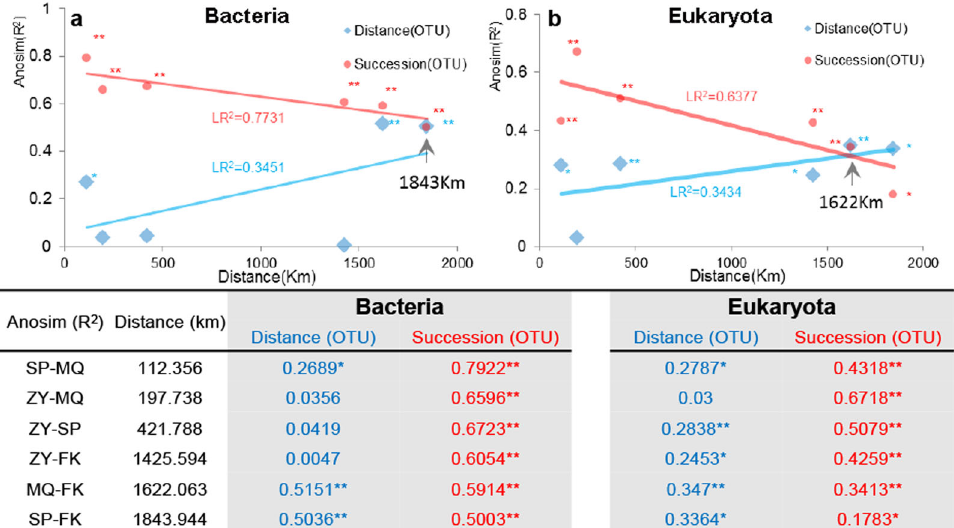
Fig. 2 Community differences varied with distance in succession and geography at regional scales. Sample sites contained FK, ZY, MQ, and SP (see Fig. 5). Bacterial ( a ) and eukaryotic ( b ) community differences were compared based on Bray – Curtis distance at operational taxonomic unit level on succession (red line) and distance (blue line). Linear regression (LR) was performed between ANOSIM ( R 2 , permutation test = 999, *<0.05, **<0.01) and distance